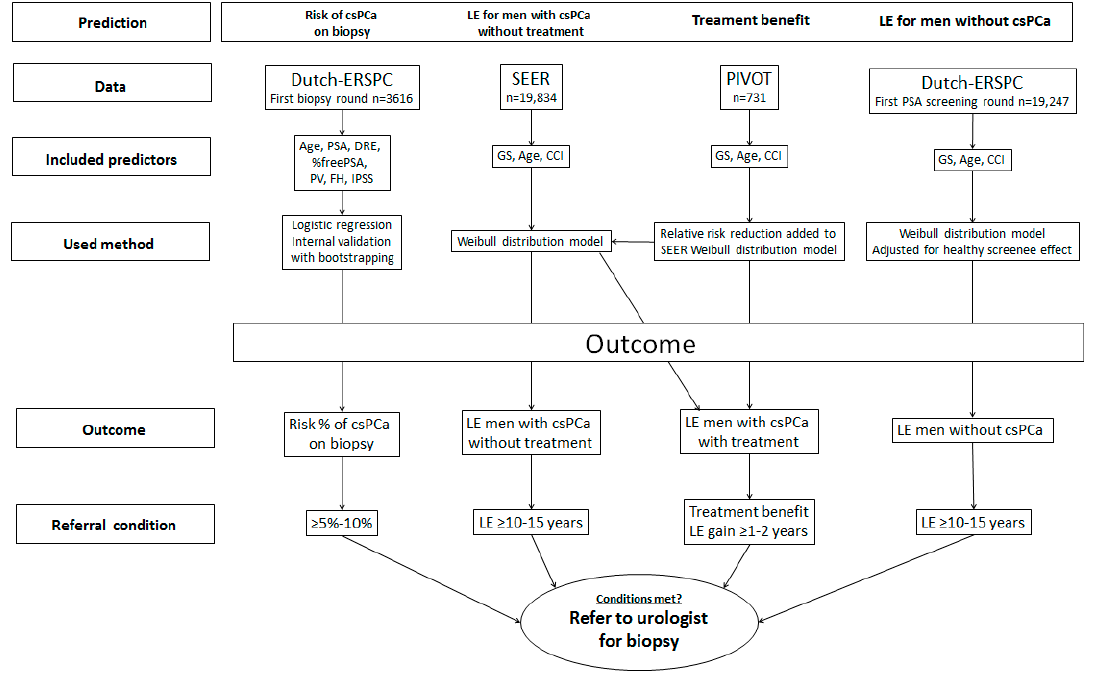
Figure 1. Flowchart of development of prediction model predicting risk of csPCa on current biopsy, overall life expectancy, and treatment benefit for each individual patient. LE: life expectancy, csPCa: clinically significant prostate cancer.